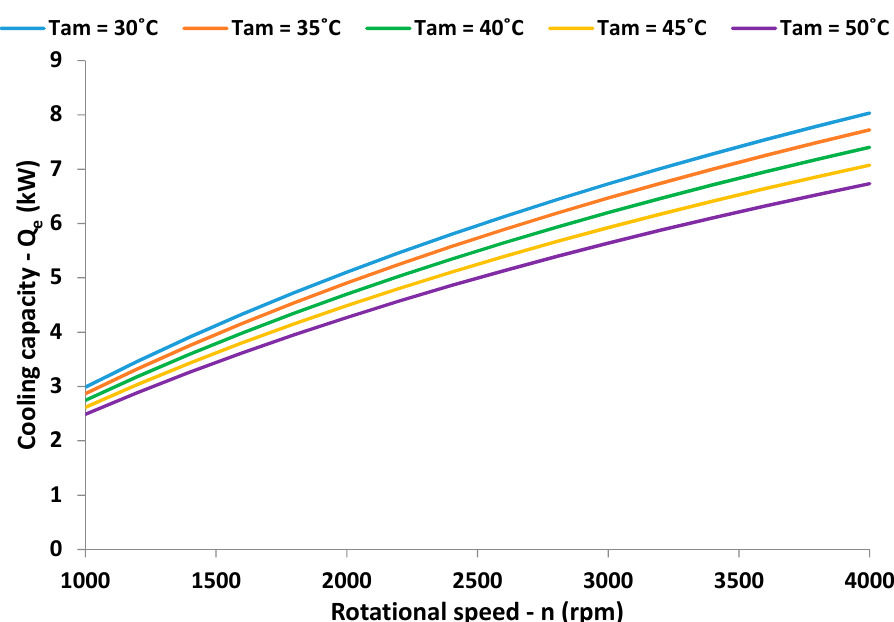
Figure 2. Coefficient of performance for different rotational speeds and ambient temperatures ( T ind = 25 °C).